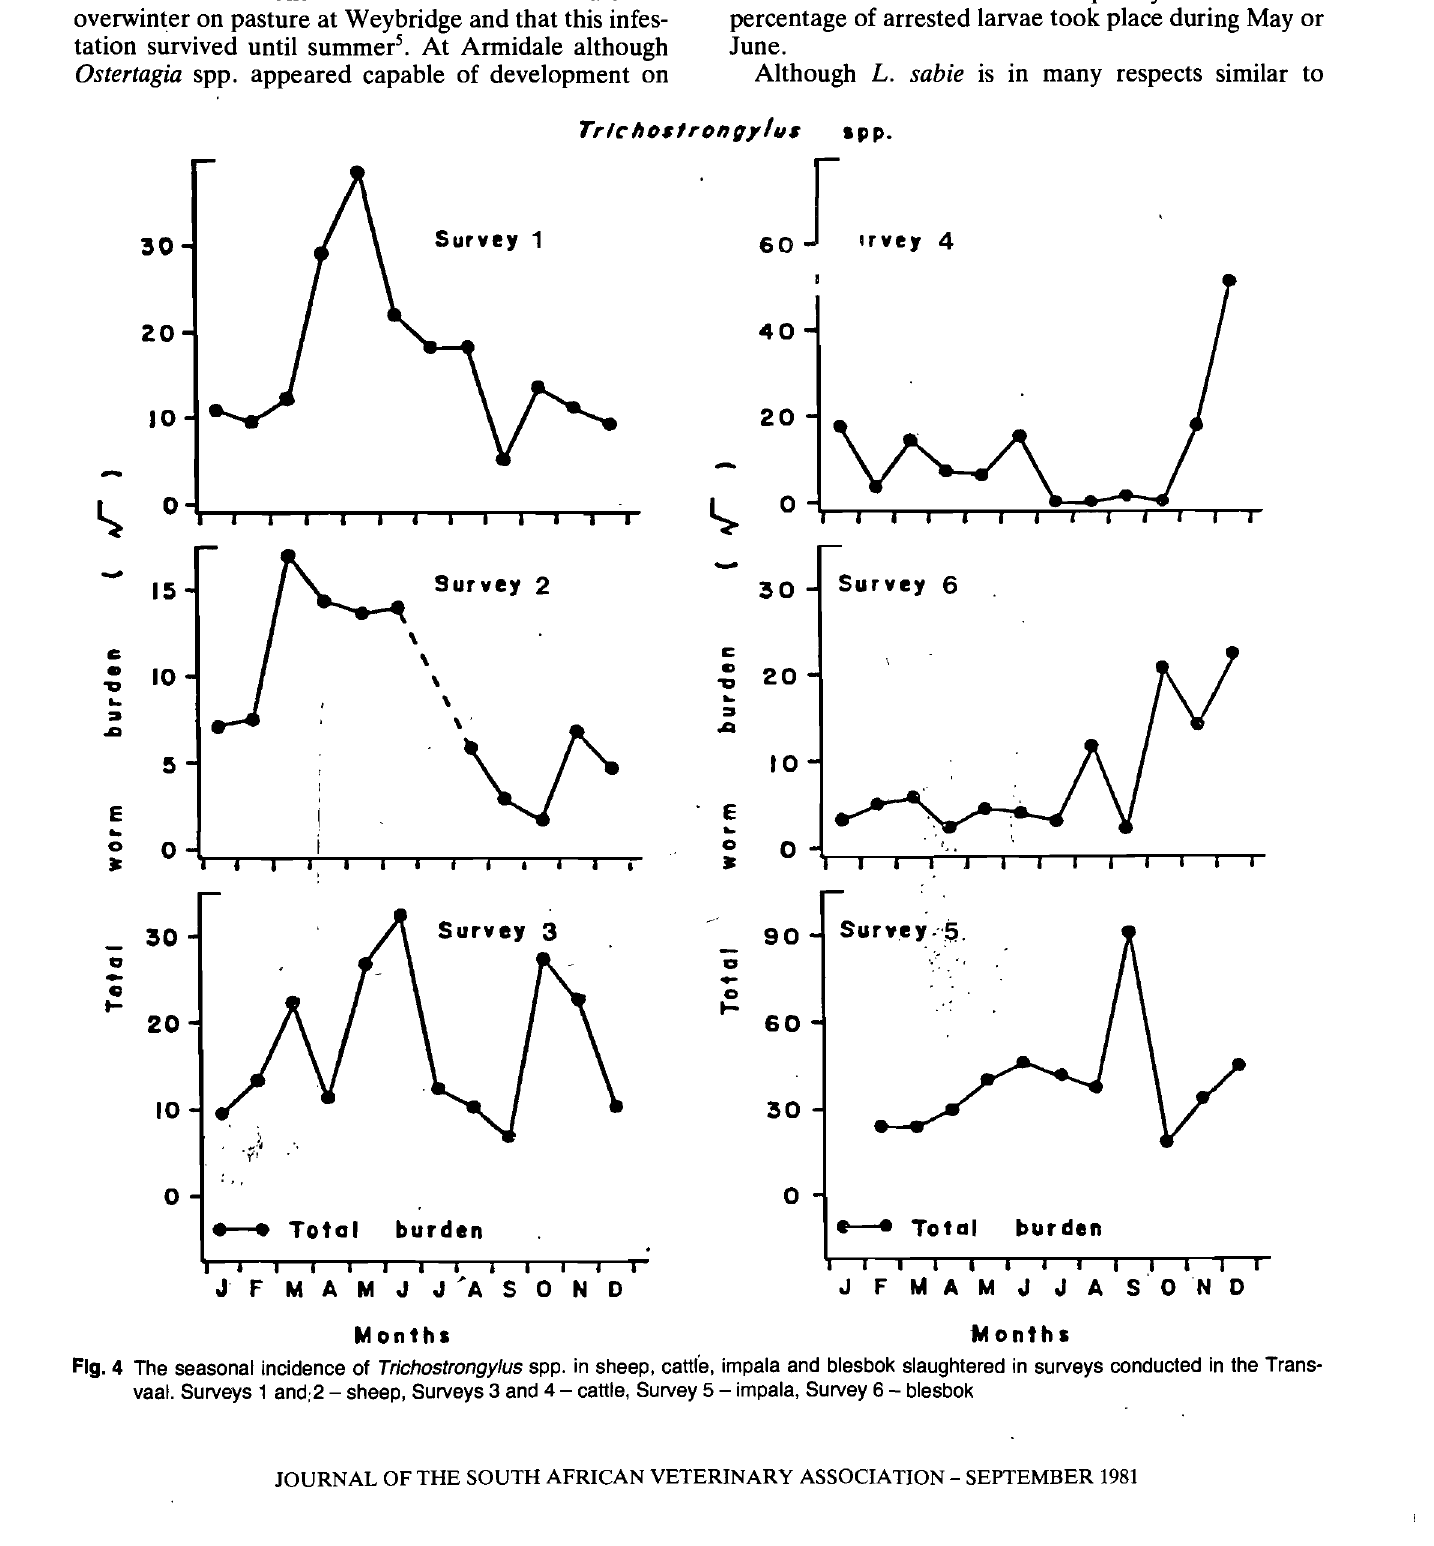
Fig. 4 The seasonal incidence of Trichostrongylus spp. in sheep, cattle, impala and blesbok slaughtered in surveys conducted in the Trans vaal. Surveys 1 and;2 - sheep, Surveys 3 and 4 - cattle, Survey 5 - impala, Survey 6 -